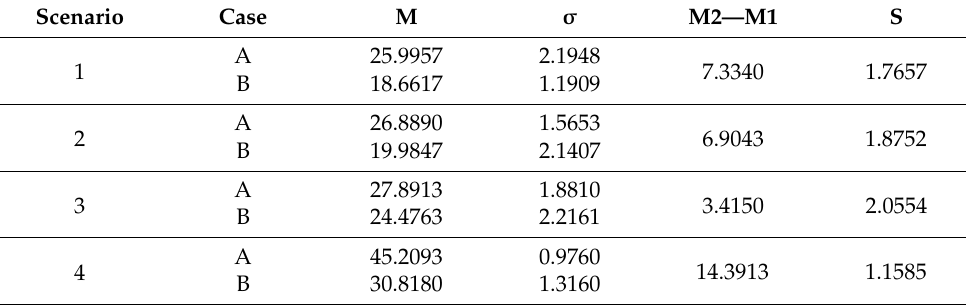
Table 11. Updated parameters used for Cohen’s